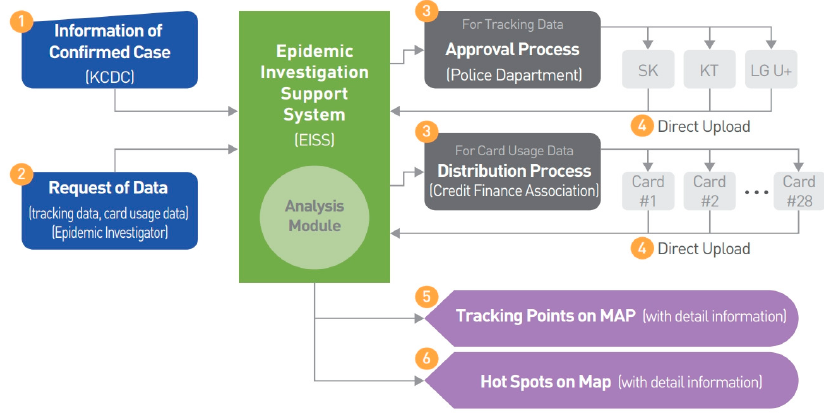
Figure 7. Korea’s epidemiological investigation support system [30].